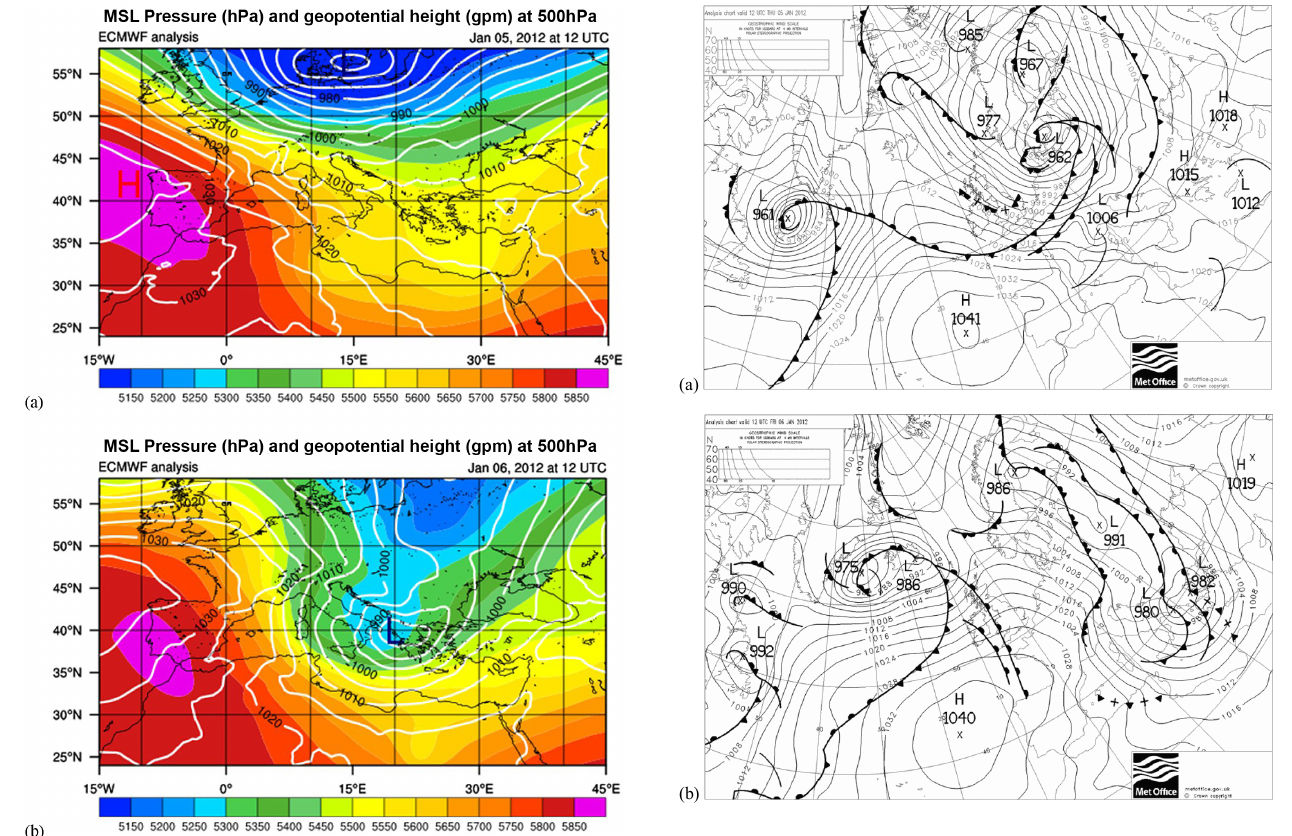
Figure 10. Surface pressure analysis map (mb) for (a) 5 January at 12:00UTC (b) 6 January at 12:00UTC, 2012. The maps derived from UK Met office surface analysis